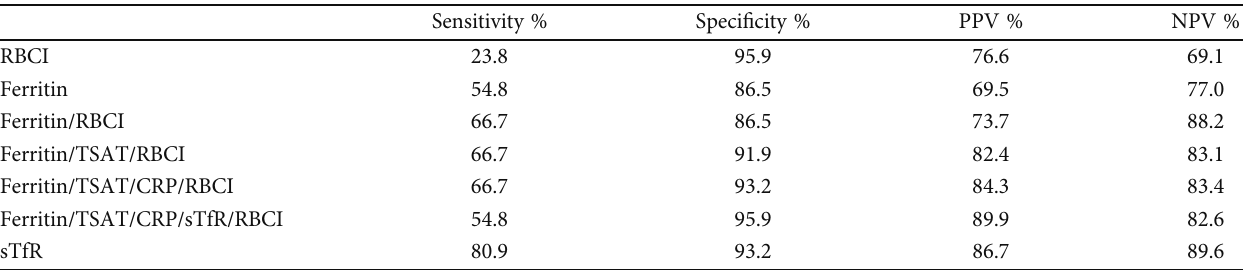
Table 3: Sensitivity, speci fi city, and predictive values of sTfR and standard parameters of iron status alone and in combination for the diagnosis of IDA or ACD/IDA ( N = 21 ) in patients with CRP ≤ median = 24 : 1mg/l ( N = 58 ). Sensitivity %